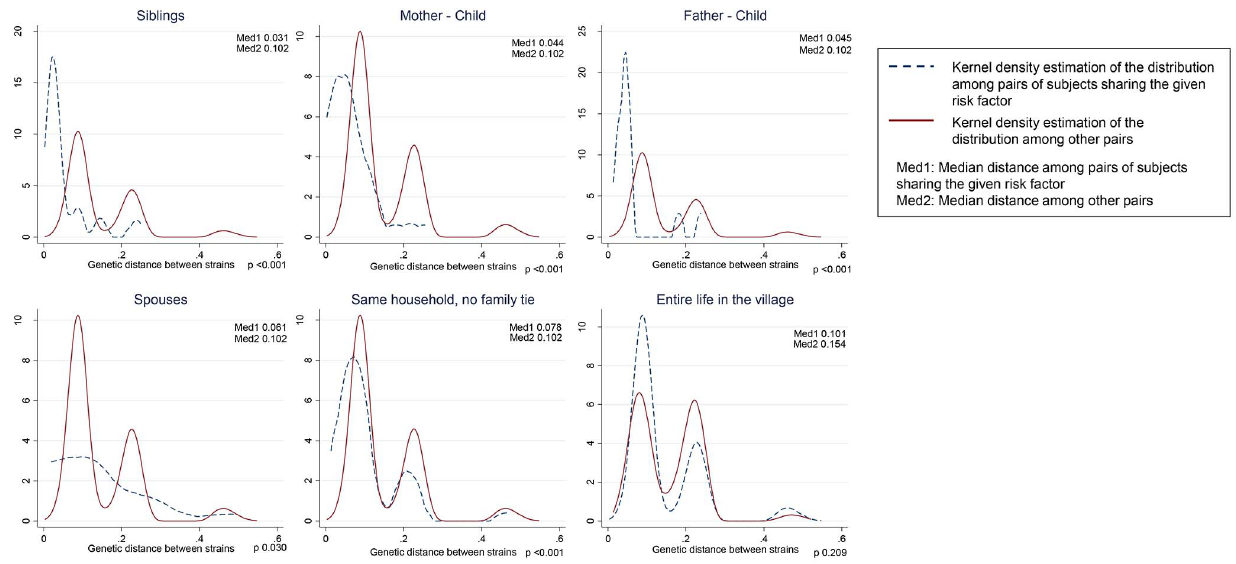
Figure 2. Distributions of viral genetic distances depending on household/family ties (n=133). Among non-exposed (continuous line), the three peaks correspond to genetic distance among individuals belonging to the same subtype (left), to the same genotype, but not the same subtype (middle), and to different genotypes (right).